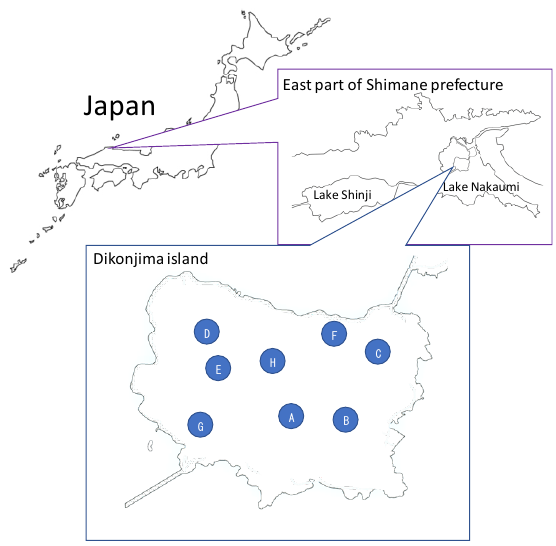
Figure 1. Study sites and location of sampling farms.